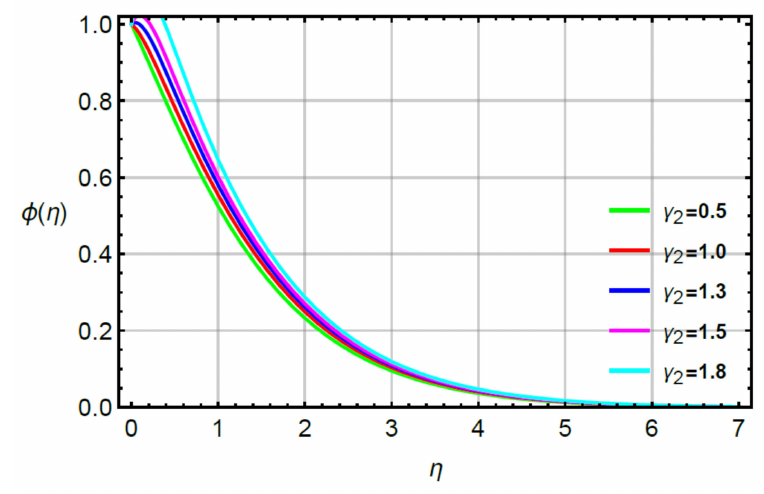
Figure 14. Behavior of φ ( η ) for γ 2 when R = 0.1, Sc = 0.6, α 1 = 0.2 = α 2 , M = 0.1, δ = 0.8. Table 2. Comparative analysis for dimensionless stress against R and γ by fixing the other parameters.